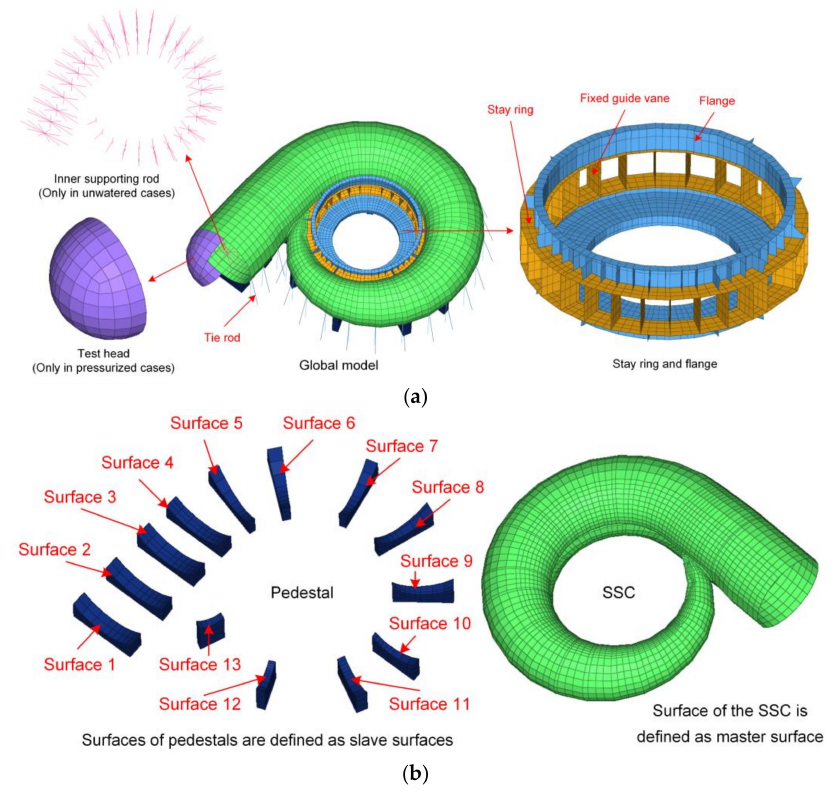
Figure 7. FE model of the SCS: ( a ) global model of the numerical simulation; ( b ) surfaces of contact